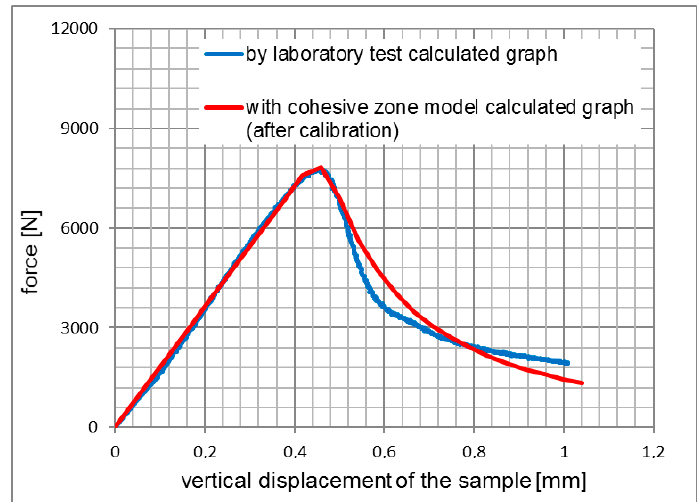
Figure 5. Comparison of the force-displacement curves from asphalt surface layer. Materials 2019 , 12 , x FOR PEER REVIEW